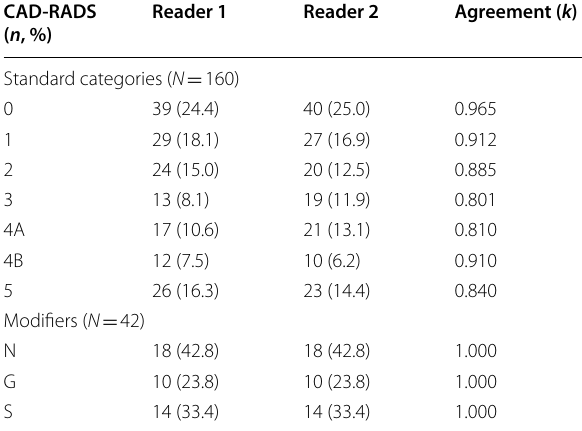
Table 4 CAD-RADS assessment categories between the two readers. The inter-observer agreement, computed with Cohen’s k statistics, was almost perfect for conventional